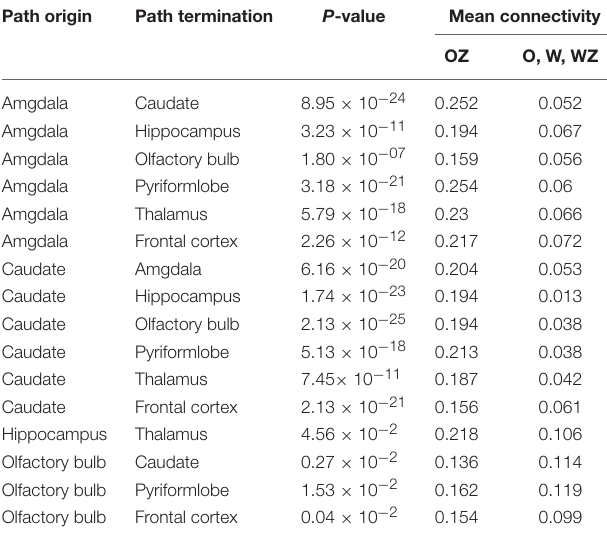
TABLE 1 | Paths with significant increase in connectivity strength for the condition of odorant + zinc nanoparticles (OZ) compared to conditions of odorant (O), water vapor + zinc nanoparticles (WZ) and water vapor alone